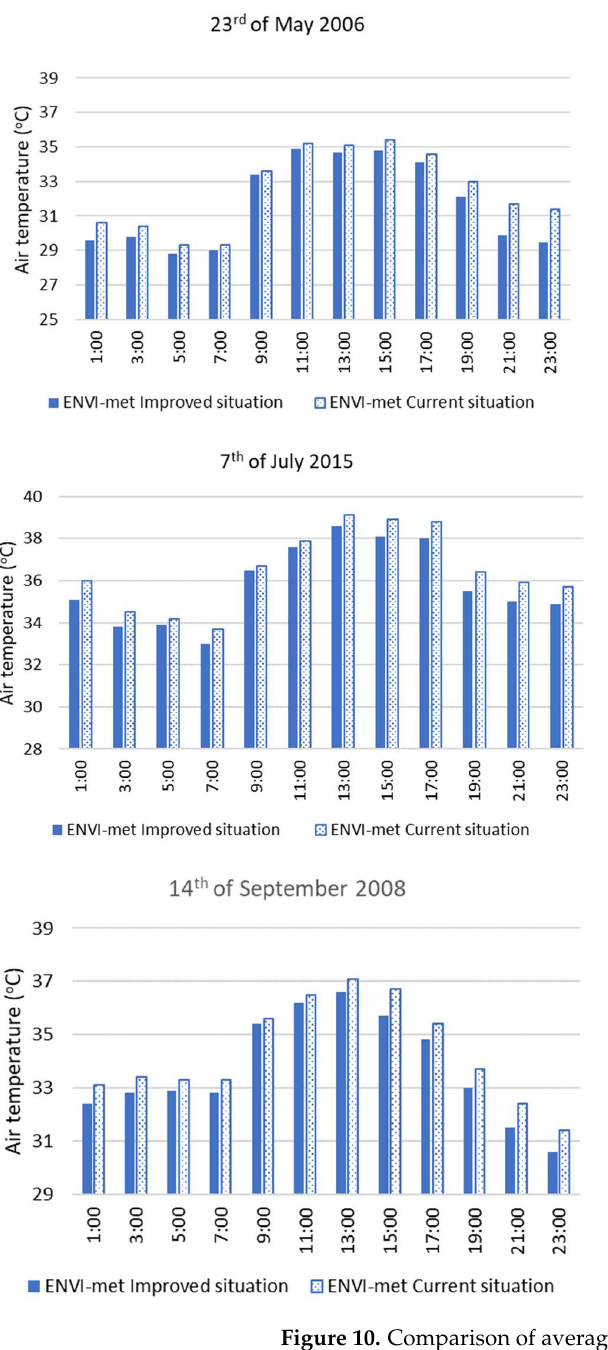
Figure 10. Comparison of average air temperature for the existing v. amended case study.